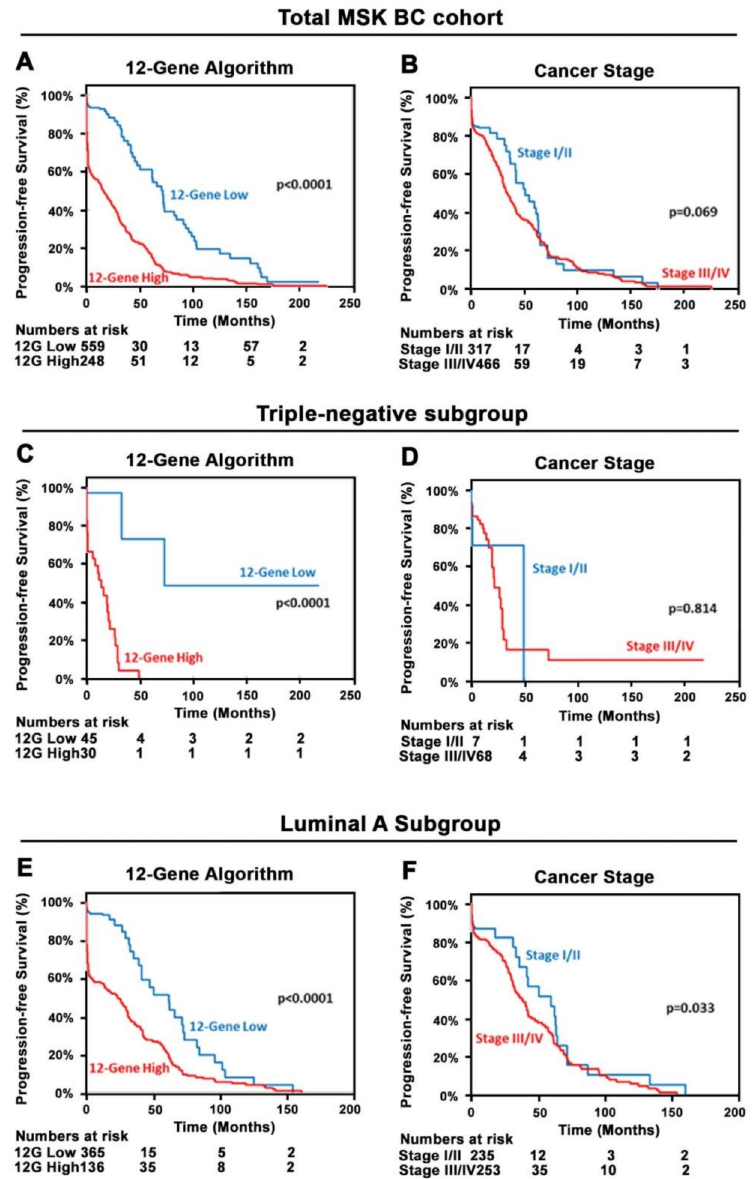
Figure 5. Kaplan–Meier survival analyses of the 12-Gene Algorithm and cancer stage for predicting progression-free survival in the MSK Cohort ( n = 807). ( A , B ) Kaplan–Meier survival curves of the 12-Gene Algorithm in ( A ) and cancer stage in ( B ) in the MSK Cohort ( n = 807). ( C , D ) Kaplan–Meier survival curves of the 12-Gene Algorithm in ( C ) and cancer stage in ( D ) in triple-negative patients ( n = 75) in the MSK Cohort. ( E , F ) Kaplan–Meier survival curves of the 12-Gene Algorithm in ( E ) and cancer stage in ( F ) in luminal A patients ( n = 501) in the MSK Cohort. Log rank p values are shown. 3.6. Validation of the 12-Gene Algorithm as an Independent PFS Predictor in the MSK Cohort We further validated the predictive power of the 12-Gene Algorithm in the MSK Cohort. The univariate Cox regression analysis showed higher predictive power of the 12-Gene Algorithm with HR of 4.4 (95% CI 3.4–5.7; p < 0.0001) than cancer stage with HR of 1.3 (95% CI 0.8–1.7; p = 0.072) (Table 5). A similar result was observed in the multivariate Cox